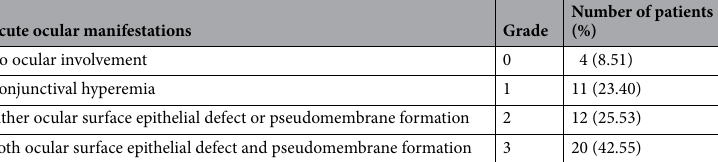
Table 2. Acute ocular severity grading of Stevens–Johnson syndrome and toxic epidermal necrolysis 27 .